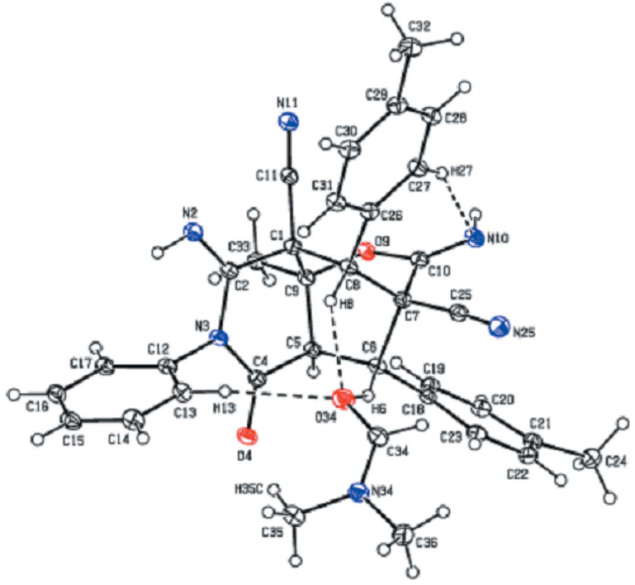
Figure 2 The molecular entities of the title compound, showing the atom labelling and displacement ellipsoids drawn at the 30% probability level. C— H (cid:2)(cid:2)(cid:2) O and C—H (cid:2)(cid:2)(cid:2) N hydrogen bonds are indicated by dashed lines.